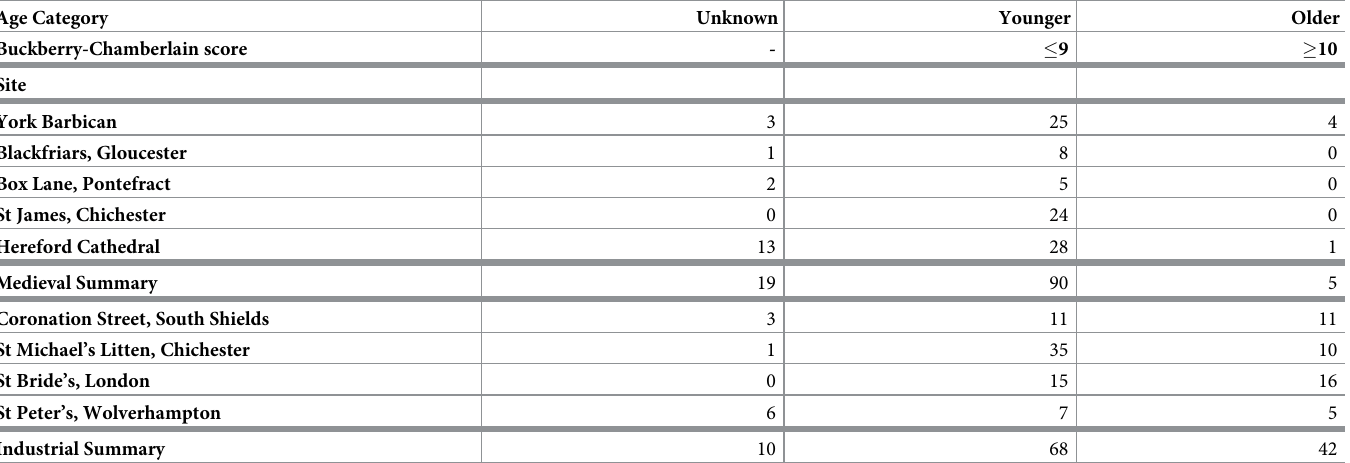
Table 3. Age-at-Death distribution using the Buckberry-Chamberlain method (2002) of the individuals selected from the assemblages examined and used to per- form OFA. Age